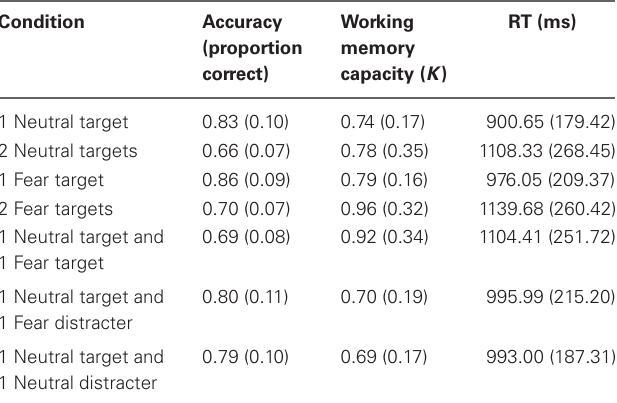
Table 1 | Means and standard deviations for accuracy, working memory capacity ( K ), and reaction time (in milliseconds) for each